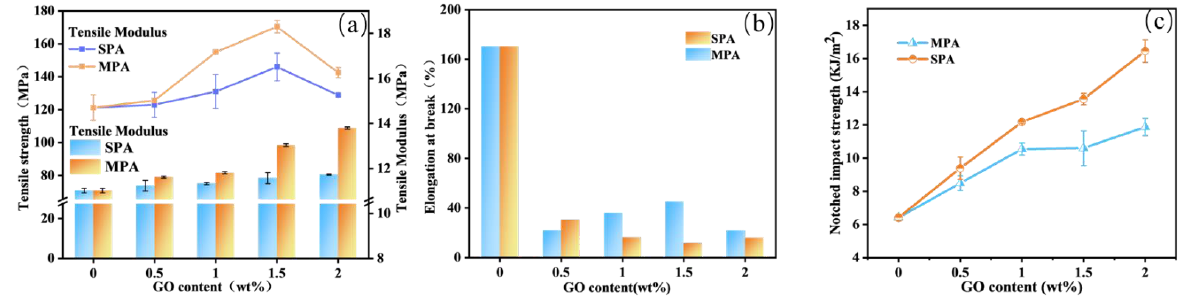
Figure 13. Mechanical parameters of SPA composites and MPA composites: ( a ) Tensile strength and Tensile modulus; ( b ) Elongation at break; ( c ) Notched impact strength. Table 5. Mechanical properties of SPA composites and MPA composites.